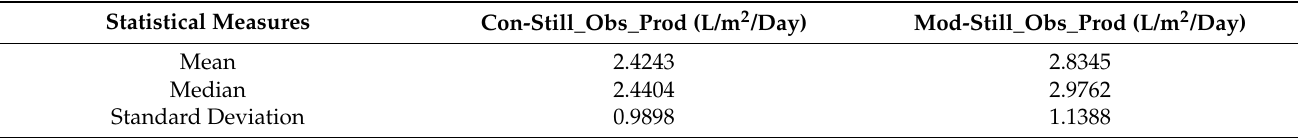
Table 9. Important statistics for the con-still and mod-still.